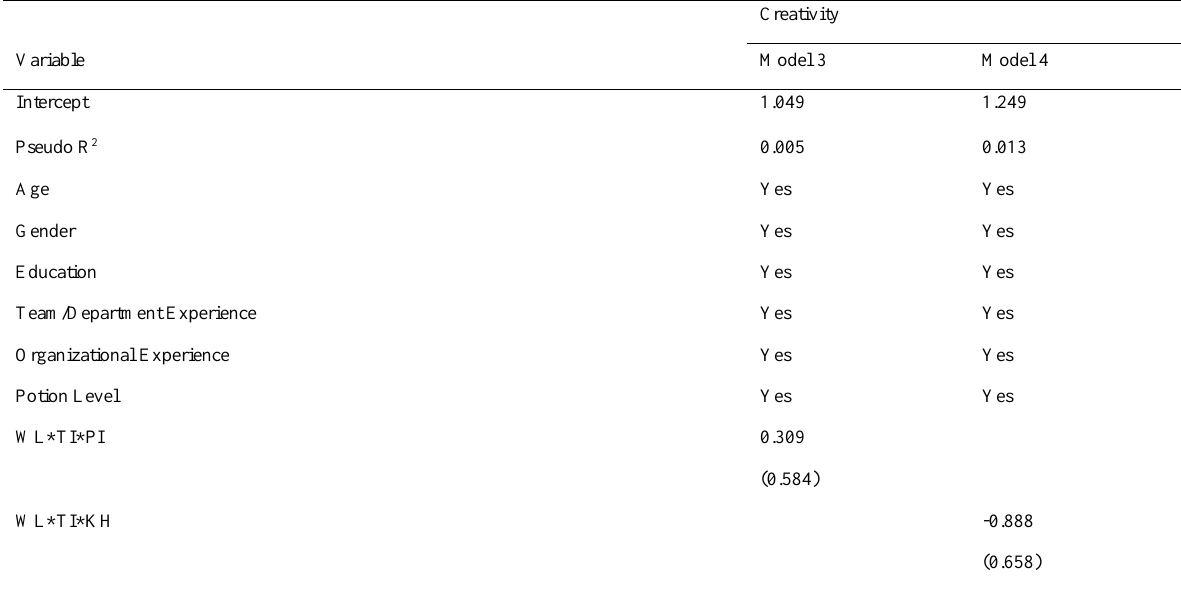
Table 3: Summary of regression analysis for moderated effect of team